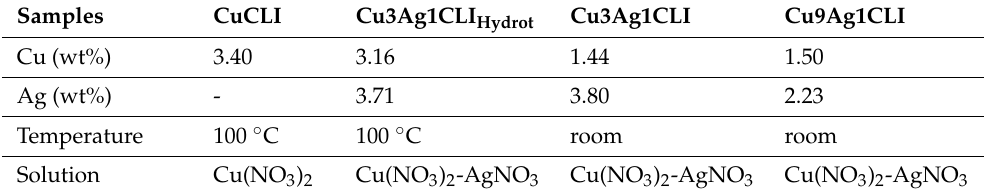
Table 2. Copper and silver contents and temperature of exchange for the samples used in this